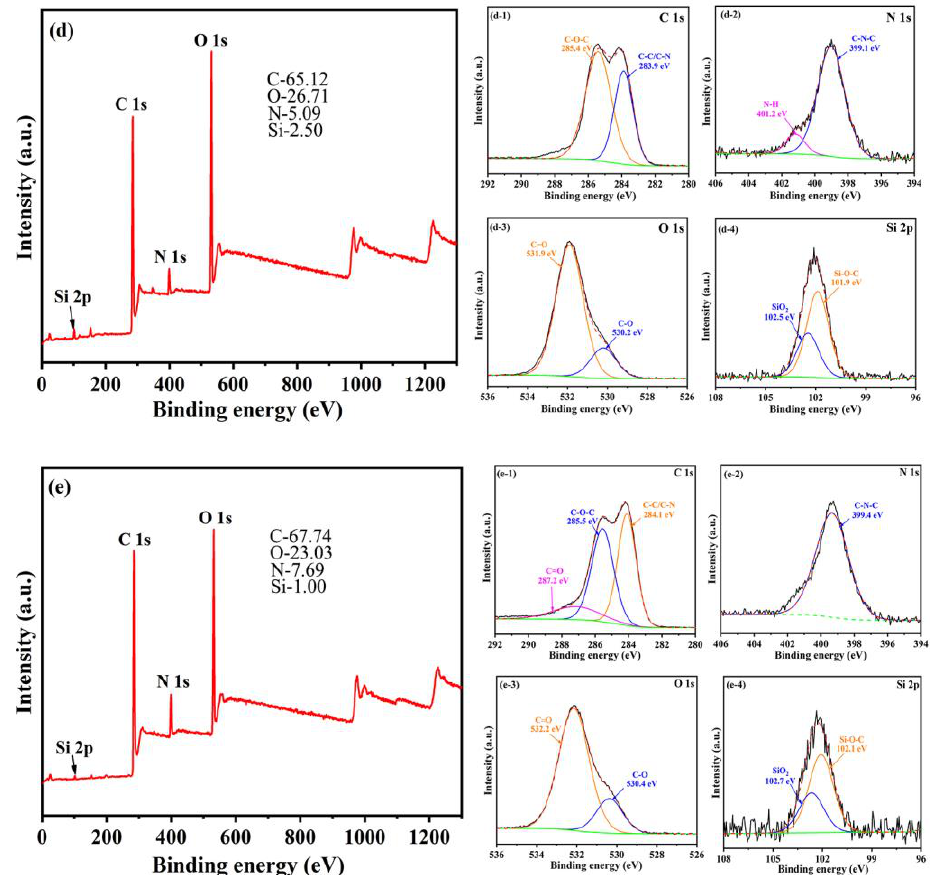
Figure 5. Fully scanned XPS spectra and zoomed spectra of C1s, N1s, O1s, and Si2p. (a-1) – (a-4) C1s, N1s, O1s, and Si2p spectra of UWF; (b-1) – (b-4) C1s, N1s, O1s, and Si2p spectra of MWF1; (c-1) – (c-4)